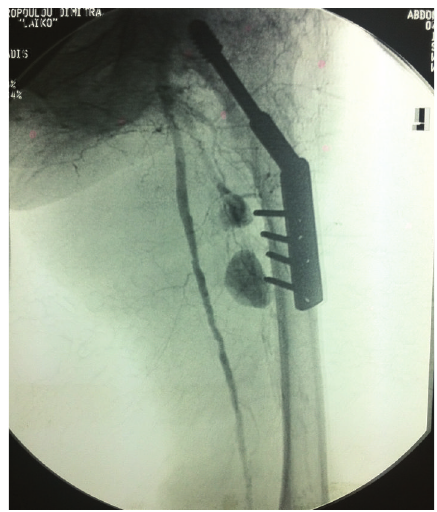
Figure 2: Extravasation of the contrast agent in the deep intramus- cular space of the thigh. Superficial femoral artery is visibly patent.